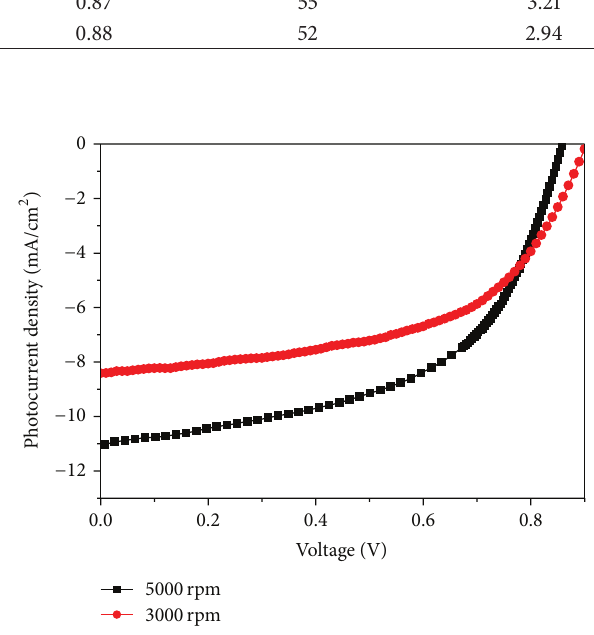
Figure 5: 𝐽 - 𝑉 characteristics of OTFSCs device of PCDTBT:PC 71 BM ratios (1: 4) prepared in o-DCB with different PEDOT :PSS layer thickness. 𝐽 - 𝑉 measurement. The thickness of PEDOT : PSS layers was varied by changing the spin speed from 3000 rpm to 5000 rpm and active layer thickness kept constant with 1 : 4 ratio of PCDTBT : PC 71 BM. The 𝐽 - 𝑉 parameter and device performance of PCDTBT : PC 71 BM based OTFSC device with respect to PEDOT : PSS layer thickness are given in Table 4. Figure 5 shows the 𝐽 - 𝑉 characteristics of PCDTBT : PC 71 BM based OTFSC device with different thicknesses of PEDOT : PSS